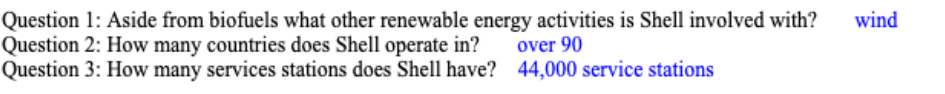
Figure 3. A paragraph from Wikipedia and three associated questions together with their answers, taken from the SQuAD